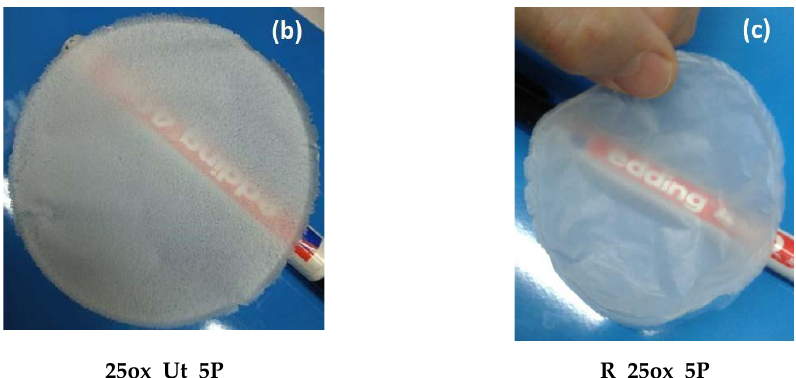
Figure 9. ( a ) Stress and strain of the CNMF films, ( b , c ) photographs of 25% oxalic acid CNMF films obtained by pre-treatments with rotary homogenizer and the PFI refiner, respectively.